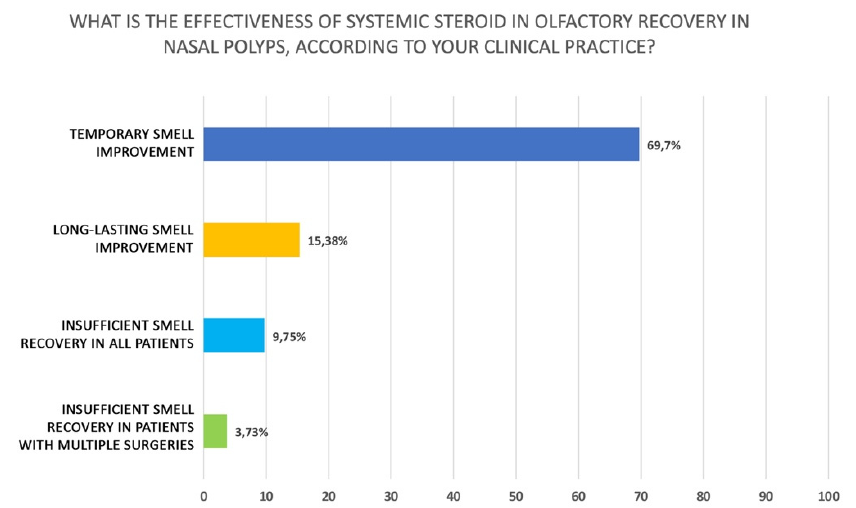
Figure 6. Perceived efficacy of oral corticosteroids in restoring olfaction (Q36 of Supplementary Materials File).